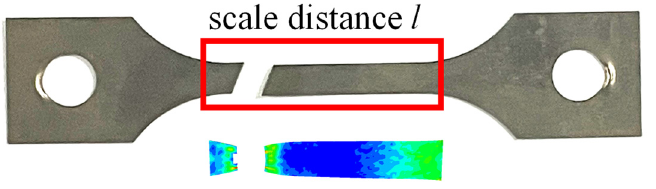
Figure 9. Comparison of simulated and tested tensile breaks of the material after siliconization at 1200 °C for 120 s.